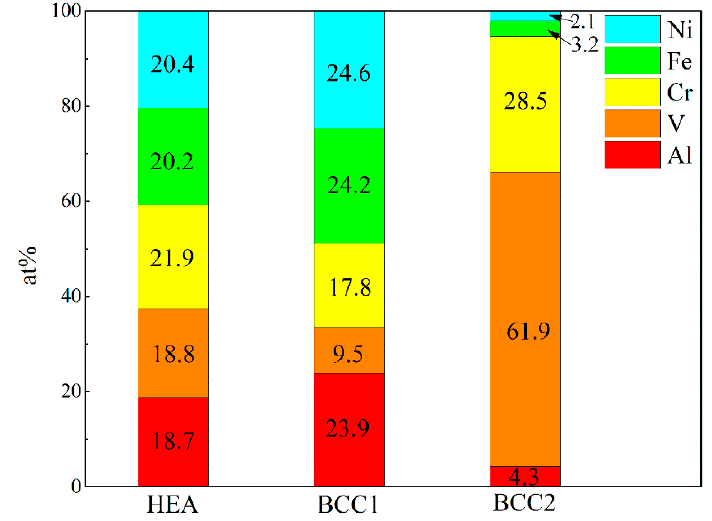
Figure 2. Columnar stacking diagram (at.%) of HEA, BCC1 and BCC2.